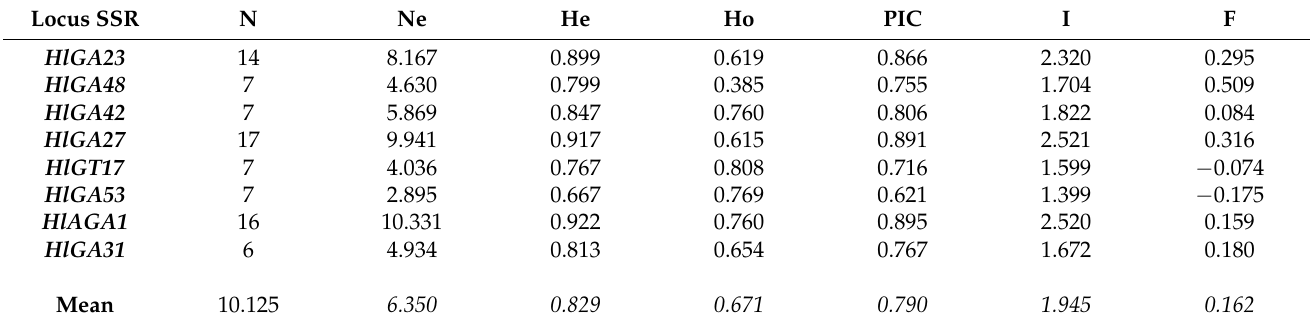
Table 5. Genetic diversity parameters among hops populations based on SSR